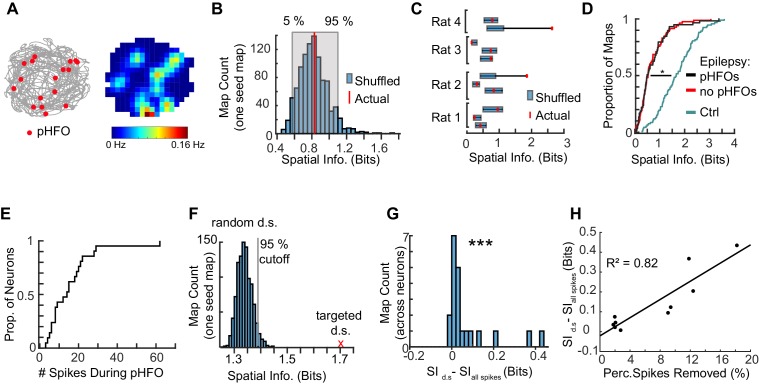
The spiking of neurons during pHFOs reduce spatial information.(A) The animal’s path is depicted in grey with the positions where pHFO events occurred overlaid as red dots. The corresponding average rate map is displayed to the right, with a peak rate of 0.16 Hz. (B) Distribution of shuffled spatial information for pHFO events shown in (A). The actual spatial information is denoted by the red line. (C) Summary of the relationship between shuffled and actual spatial information of pHFOs for all foraging epochs with frequent pHFOs. Blue bars denote 5 and 95 percentile of shuffled distributions. Red dots show actual information. (D) Distributions of spatial information of neurons recorded from control animals (cyan, n = 93 maps) compared to spatial information of neurons in animals with epilepsy recorded either during foraging epochs with ongoing pHFOs (black, n = 83 maps) or no pHFOs (red, n = 59 maps). * ≤ 0.05 Kruskal – Wallis test, Tukey Kramer post hoc. (E) Distribution of the number of spikes that occurred during pHFOs for individual neurons during foraging epochs with ongoing pHFOs (n = 21). (F) The distribution of spatial information after random down-sampling (random d.s.) was calculated to determine whether targeted removal of spikes that occurred during pHFOs (targeted d.s., shown as a red x) led to a significantly higher spatial information score than would be expected by random down-sampling. (G) Spatial information of individual neurons was improved when spikes that occurred during pHFOs were removed from the map (targeted d.s.). *** ≤ 0.001 Wilcoxon Sign Rank test. (H) The improvement in spatial information as a function of the percentage of spikes which occurred during pHFOs. Values from individual neurons are plotted as black points. Only maps that had significant improvements beyond what would be expected by random down-sampling (as shown in F) are plotted and fit with a line.